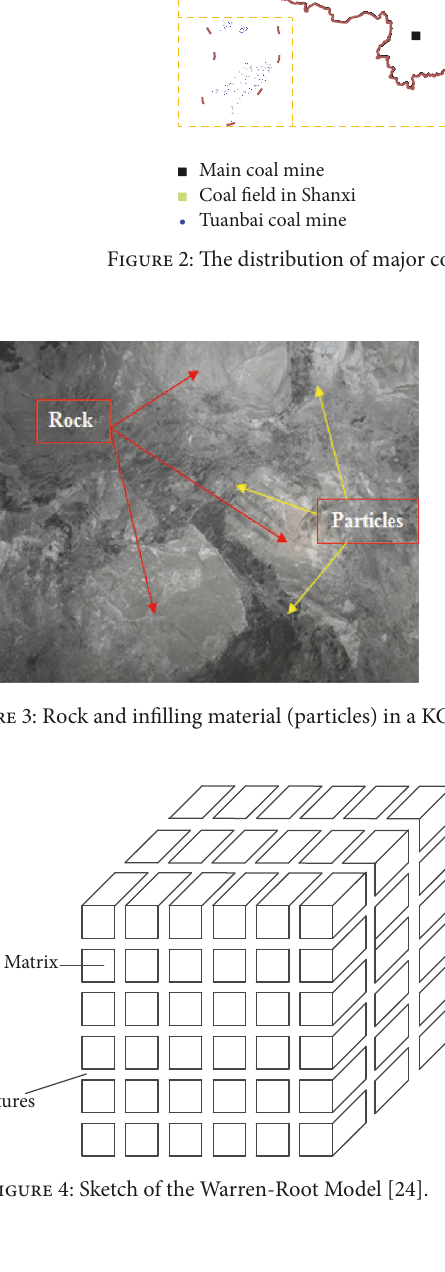
generally competent, the impact of the change in the effective stress on KCP’s permeability is insignificant. (4) The impact of erosion on the permeability change is in proportion to the change of particle concentration in the fluid.